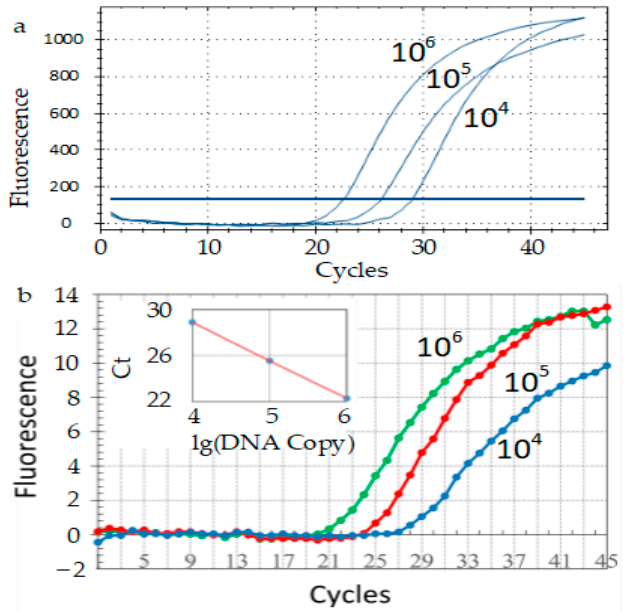
Figure 7. Results of DNA amplification of SARS-CoV-2 CDC positive plasmid. ( a ) Commercial QPCR instrument (Bio-Rad CFX Connect, Bio-Rad, CA, USA); ( b ) Homemade PCR with upgraded temperature cycle.